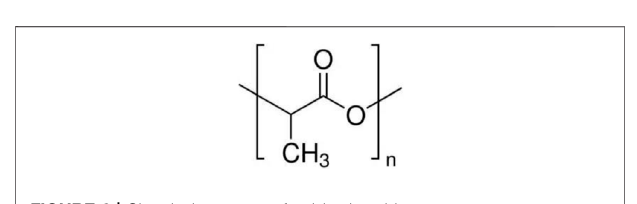
FIGURE 2 | Chemical structure of polylactic acid.